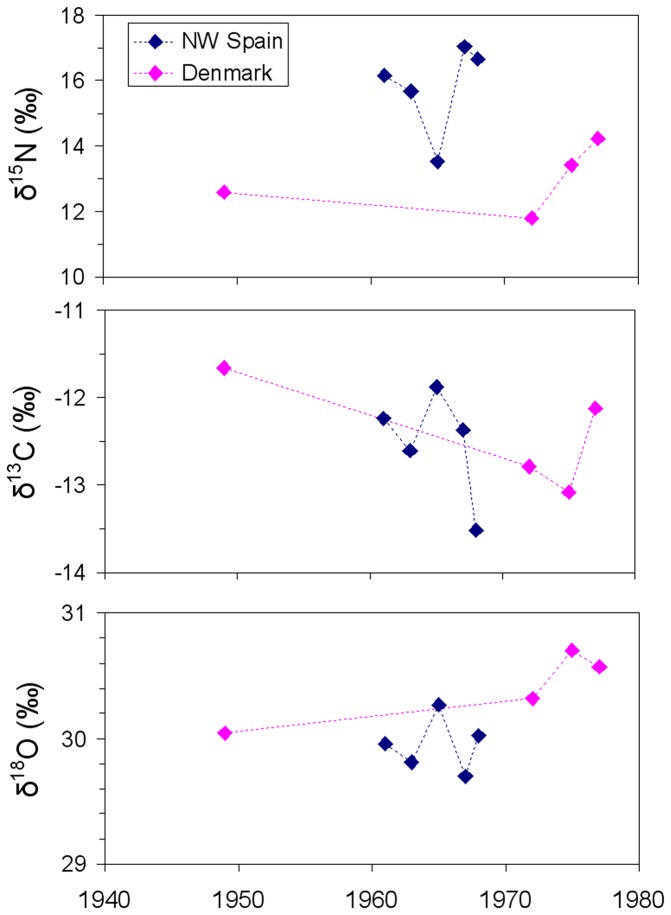
Relationship between δ15N, δ13C and δ18O values and the year of formation of the 3rd year dentinal growth layer group (GLG) in sperm whales from NW Spain and Denmark.